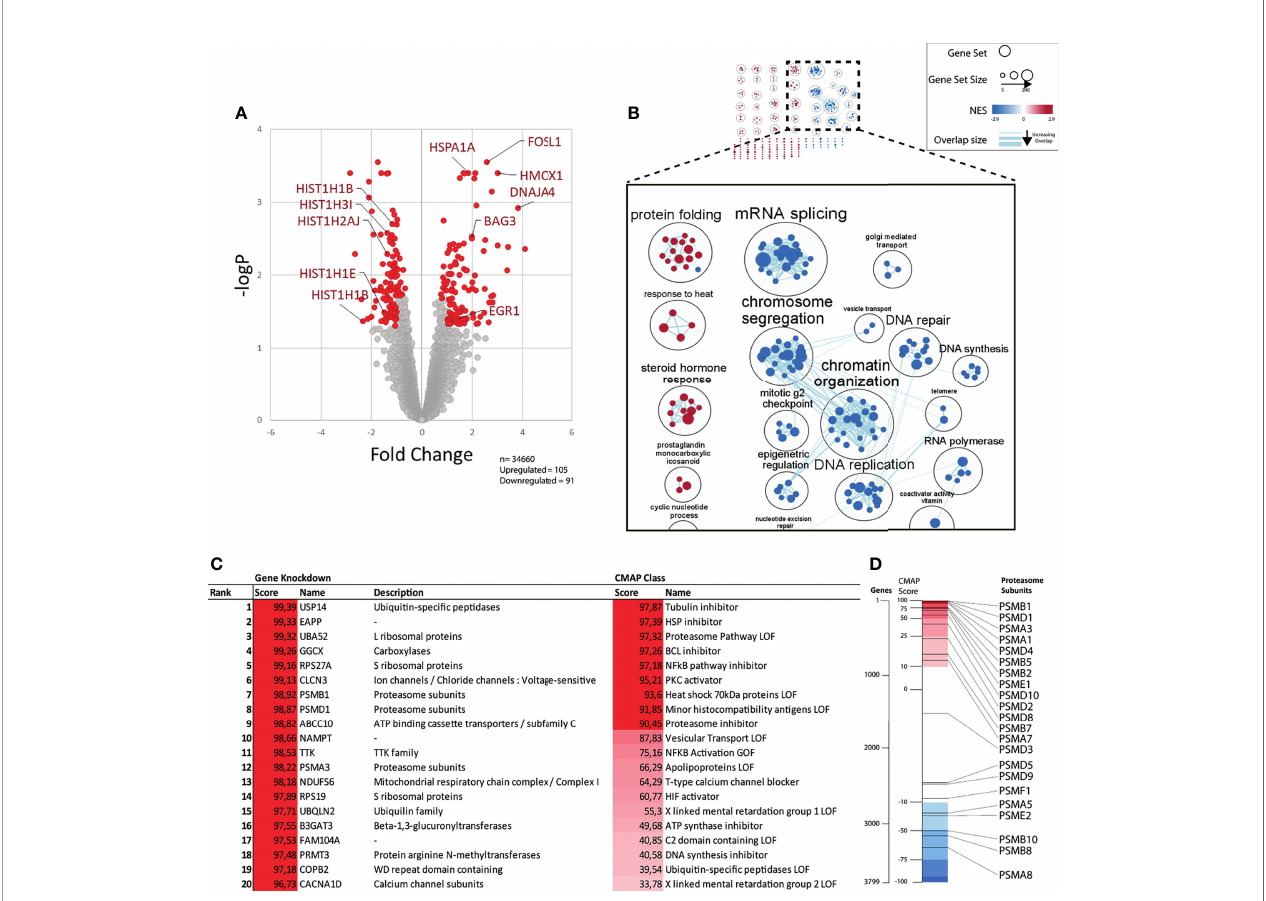
FIGURE 2 | Gene expression pro fi le after b-AP15 treatment. MCF7 cells were treated for 6h with either 1µM of b-AP15 or DMSO. Relative change in gene expression was obtained through microarray analysis. (A) Of the 34660 probes, 196 were differentially expressed. 105 were upregulated and 91 were downregulated in the relative to the control (adjusted p value < 0.05; more than 2-fold up or down regulated; n=3). Each point represents a probe. Immediate early genes (EGR1, FOSL1), HMOX1, chaperones (HSPA1A, BAG3, DNAJA4), and downregulated histones are shown. (B) Network analysis of enriched gene sets. Enriched gene sets (FDR < 0.05) were clustered based on their degree of overlap (number of similar genes). Gene sets overrepresented in upregulated genes have a positive NES (red) and downregulated genes have negative NES (blue). The top fi gure shows all the clusters. The magni fi ed set at the bottom shows the select related clusters (C) The top differentially expressed genes were analyzed using the connectivity map (CMap) to fi nd gene knockdowns or CMap classes in the CMap database that have a similar gene expression signature. Scores >90 are considered signi fi cant. (D) Bars show the position of curated gene knockdown signatures (black lines) relative to all 3799 gene knockdown signatures (spectrum) in the CMap database. Positive scores (red region) represent the correlated and negative scores (blue region) represents the inversely correlated knock-down gene